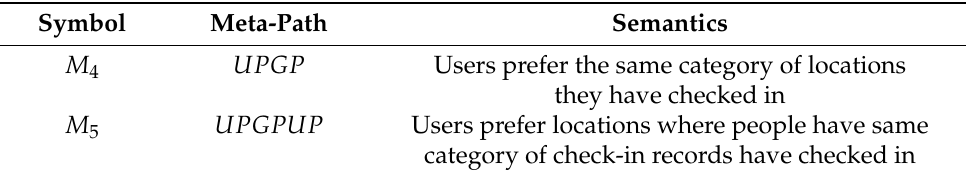
Table 1. Cont. Symbol Meta-Path Users prefer the same category of locations Users prefer locations where people have same category of check-in records have checked